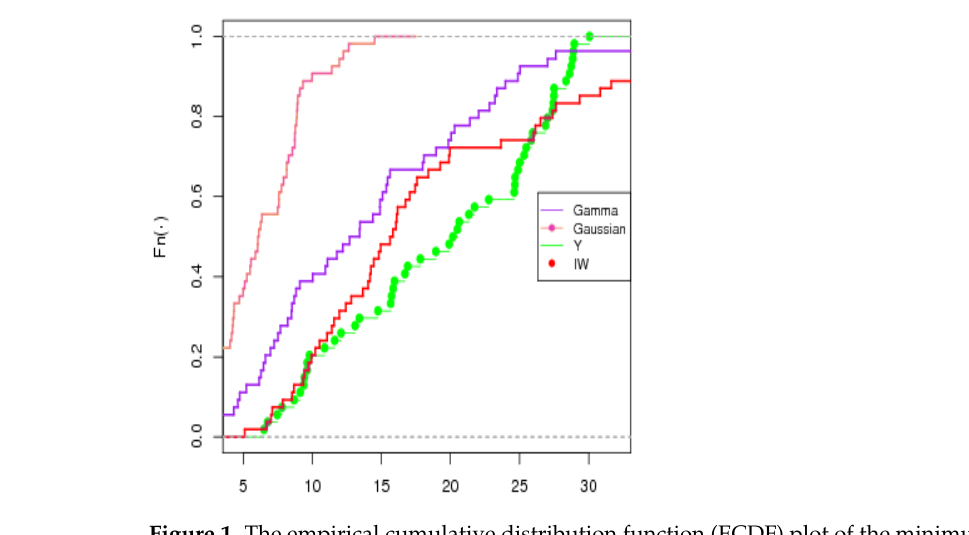
Figure 1. The empirical cumulative distribution function (ECDF) plot of the minimum temperatures ( Y ) based on IW distribution and some other distributions. Table 1. Efficiency Gamma, Gaussian, inverted Weibull Regression (IW-Reg), IW-Bayesian regression (IW-BReg) models.